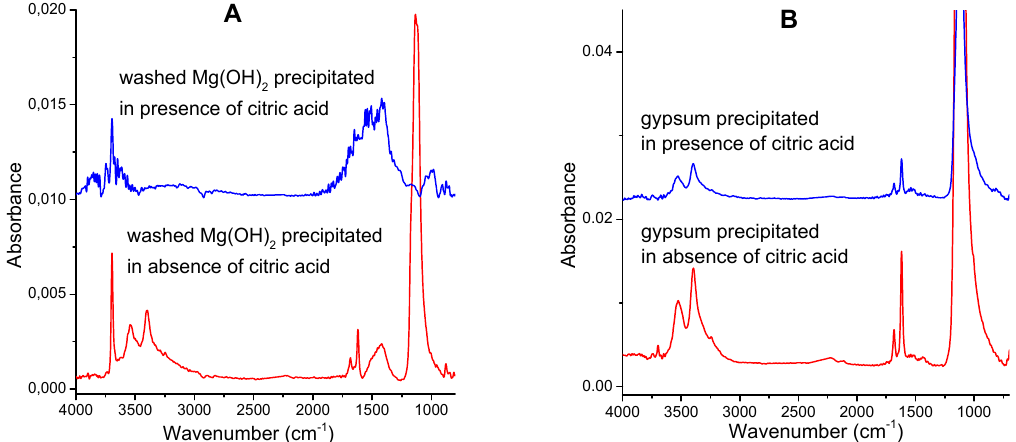
Figure 10. FT-IR spectra of the ( A ): Mg(OH) 2 and ( B ): CaSO 4 · 2H 2 O precipitates obtained from reaction mixtures containing citrate ion (upper spectra) and those in absence of the inhibitor (lower spectra), as described in the text.